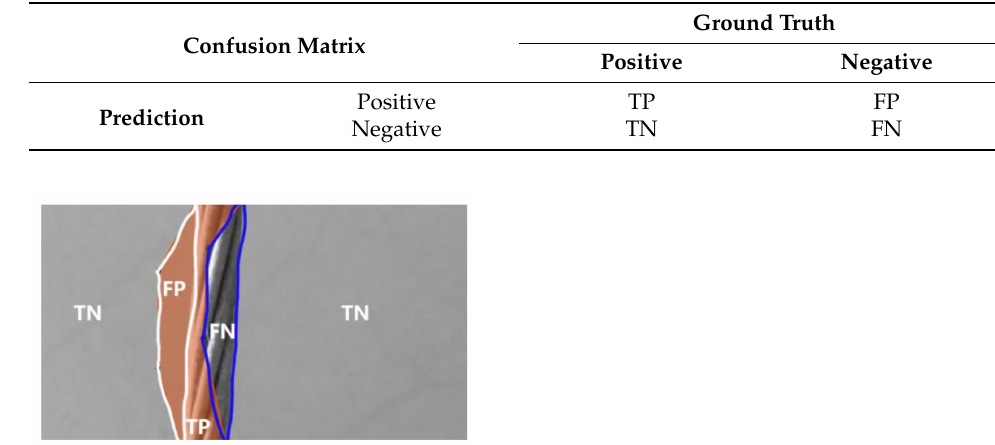
Figure 11. Schematic diagram of confusion matrix metrics for cable versus backgrounds pixel-wise